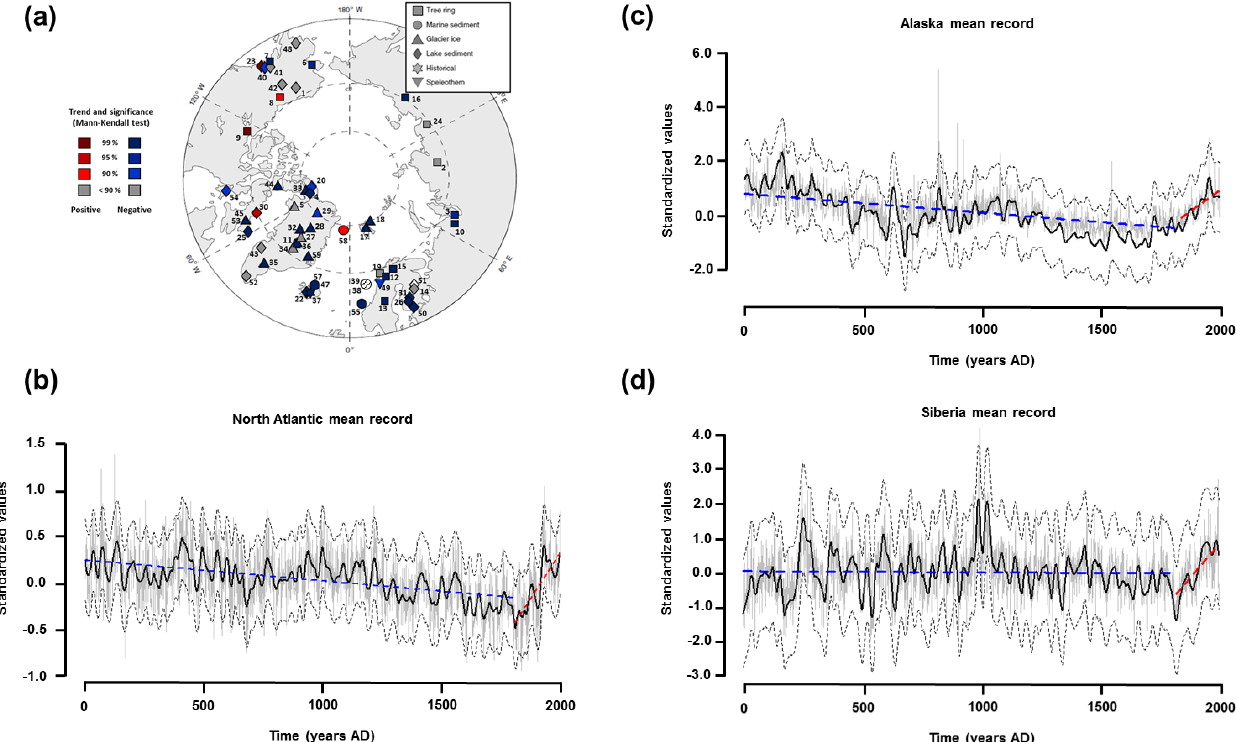
Figure 5. (a) Individual trends for each record before recent warming. The white dot highlights inconsistency between two tendencies for the same archive. North Atlantic (b) , Alaska (c) and Siberia (d) regional 50-year LOESS. Blue colors indicate a decreasing tendency whereas red colors indicate increasing trends. Dashed black lines correspond to the 95% confidence